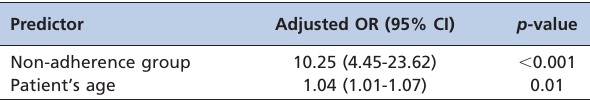
Table 4 - Independent predictors of unfavorable clinical outcomes after logistic regression.